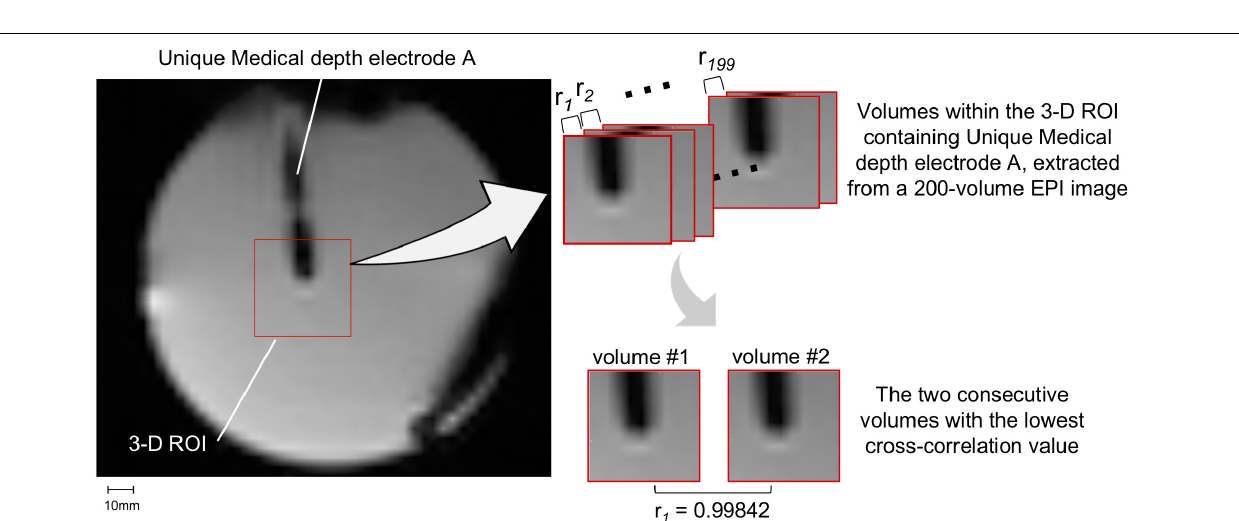
Frontiers in Neuroscience |